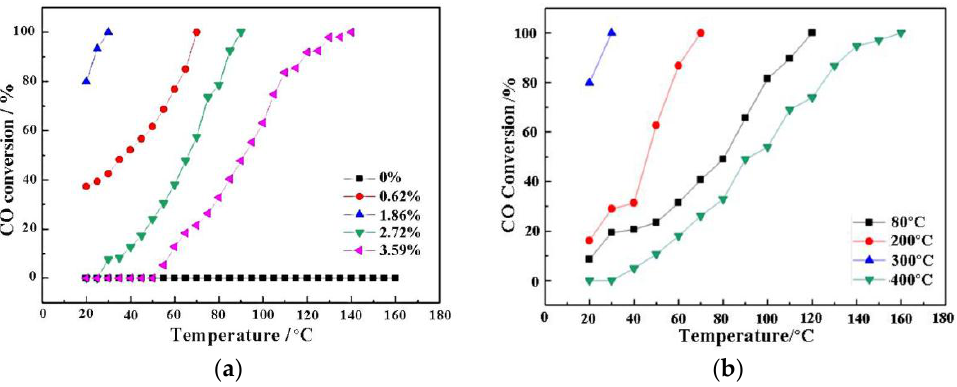
Figure 8. ( a ) Catalytic activities of different amount of Au/α-Fe 2 O 3 catalysts; ( b ) Catalytic activities of 1.86% Au/α-Fe 2 O 3 calcined at different temperature. Table 1. Comparison of catalytic performance of different gold catalysts for CO oxidation. Au Catalyst